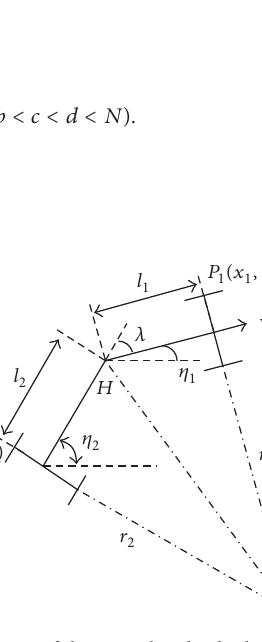
Figure 4: Geometry of the articulated vehicle while